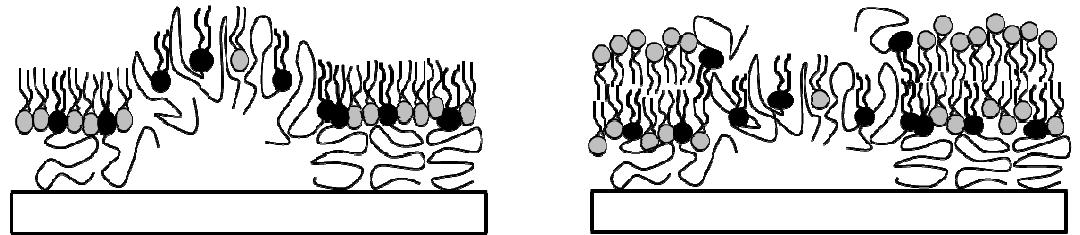
Figure 1. Schematic of stress relaxation processes in physisorbed polymer monolayer (left) and bilayer